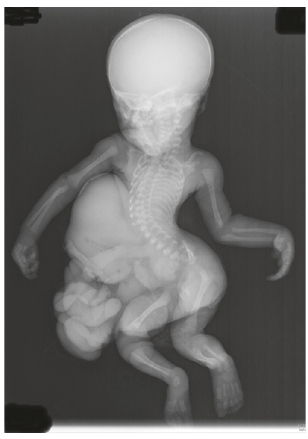
Figure 5: Infantogram showing a thoracic cage deformity, char- acterized by a narrow chest and downslanting ribs and severe kyphoscoliosis of the